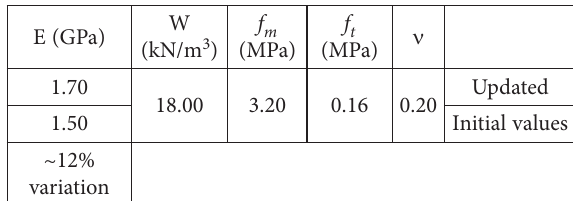
Table 4. Mechanical properties of the numerical model after